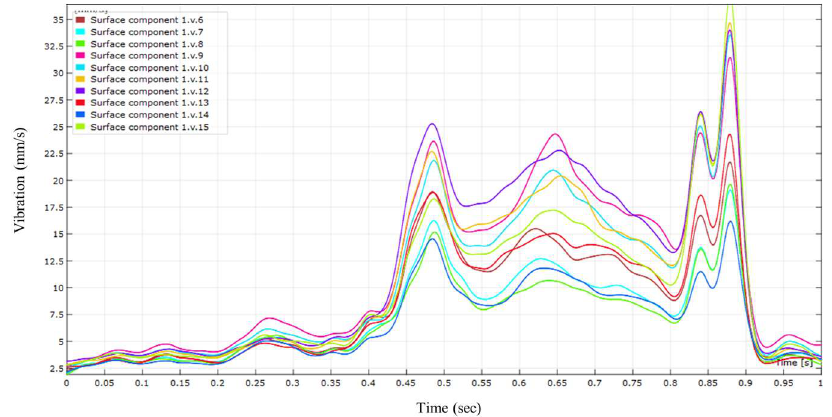
Figure 7. Vibration of rock pillars ROI after blasting.